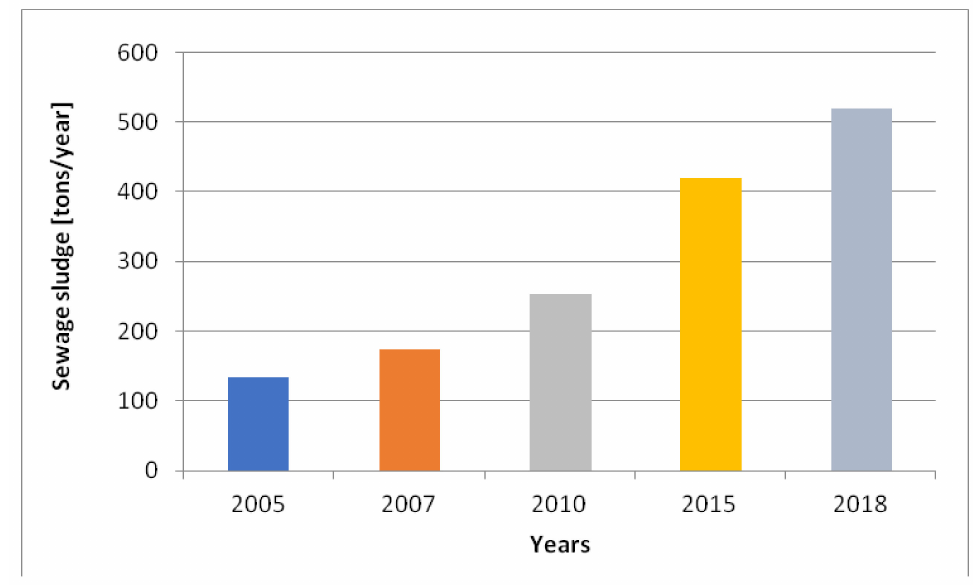
Figure 2. The amount of sludge generated in Romania [14].